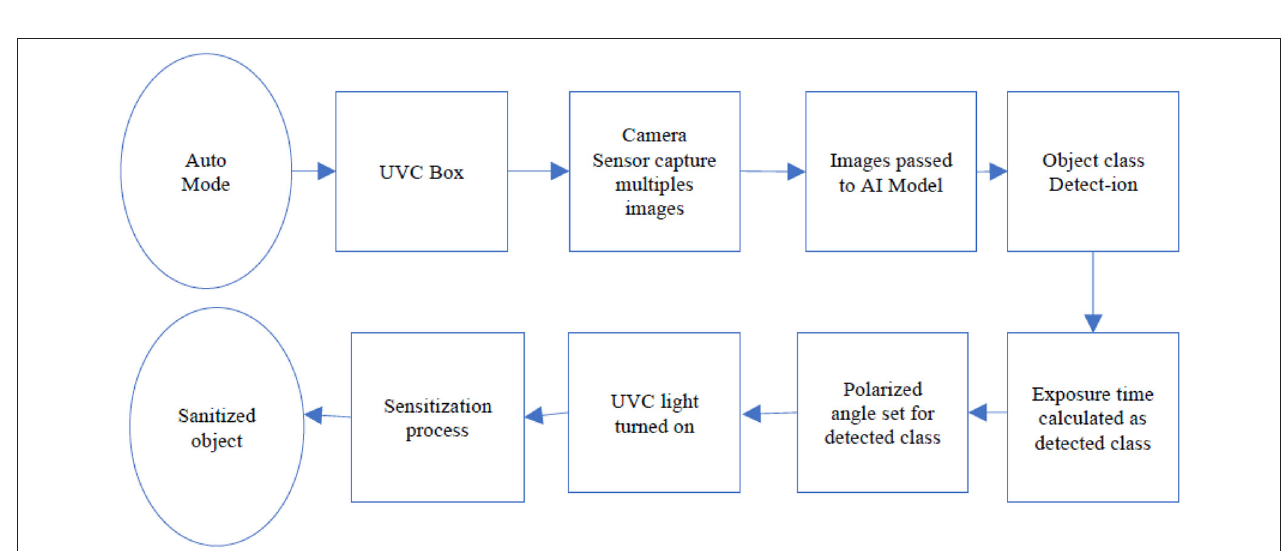
FIGURE 4 | Auto mode operation of UVC